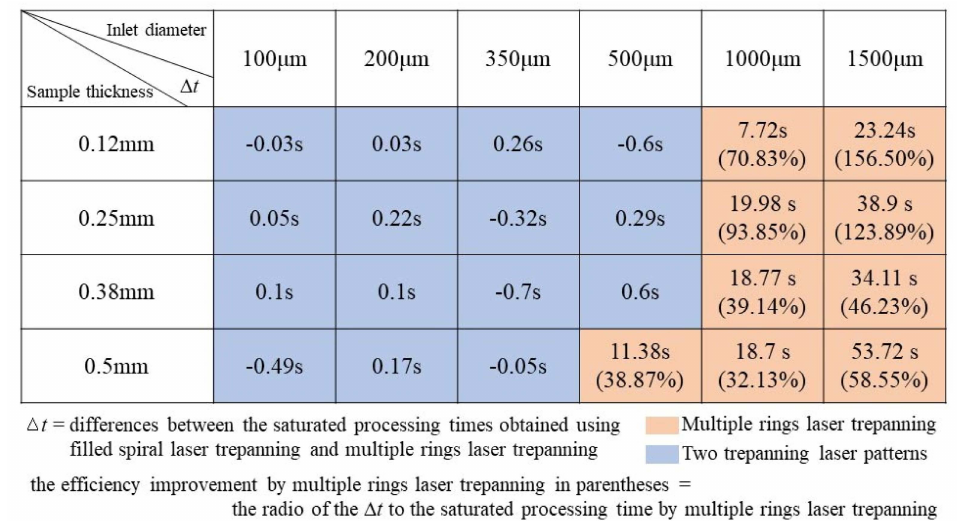
Figure 10. Optimization of trepanning patterns for high-quality holes and the machining efficiency based on the saturated processing